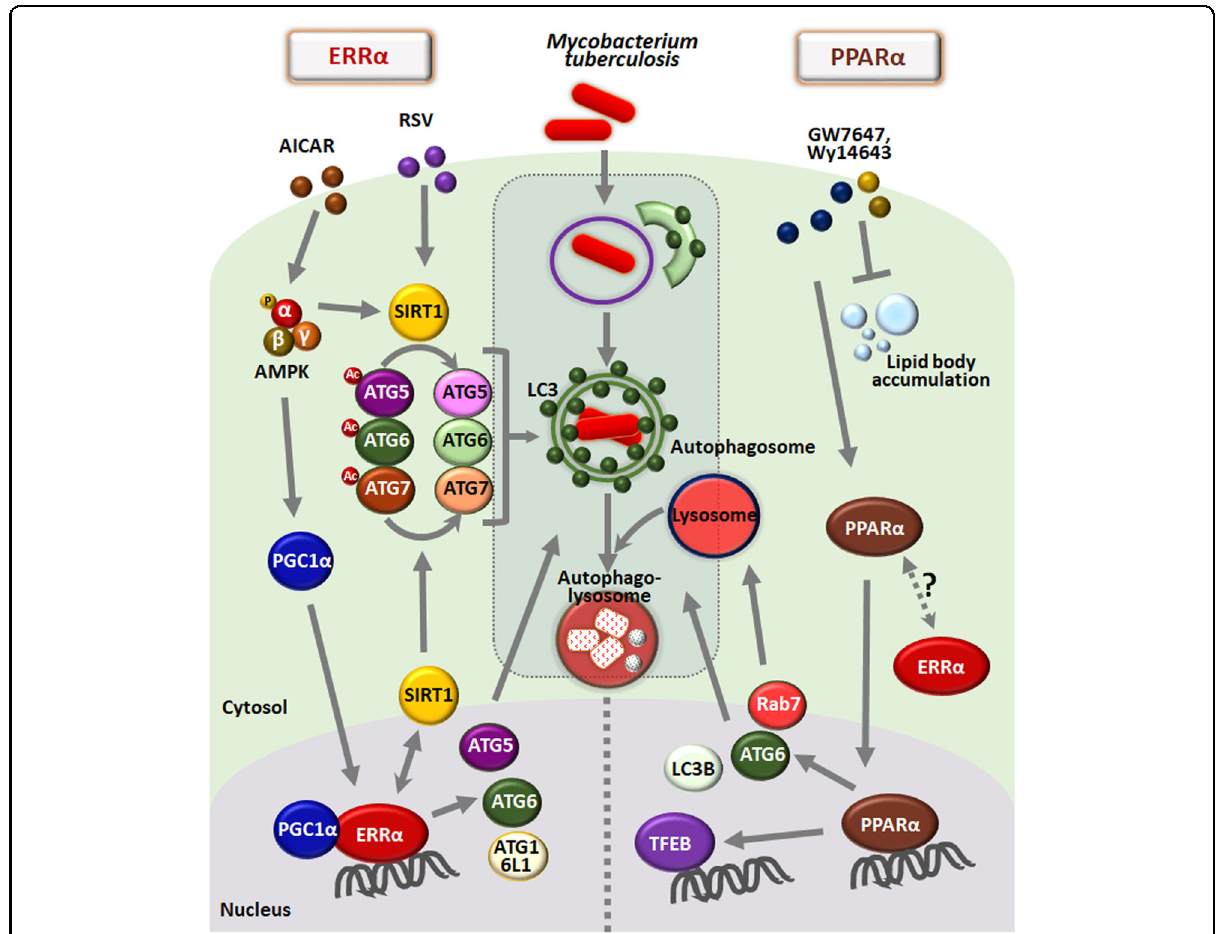
Fig. 2 The roles of ERR α and PPAR α in autophagy and host defense against Mtb infection. ( Left ) ERR α , which is induced by either AMPK or SIRT1 activation, contributes to the induction of autophagosome formation in BMDMs. ERR α is required for the transcriptional activation of several ATGs containing ERR response elements in the promoters. In addition, the cooperation of ERR α with SIRT1 promotes the deacetylation of ATG5, ATG6, and ATG7, thereby activating autophagy at the posttranslational level. ERR α -mediated autophagy activation results in increased phagosomal maturation and antimicrobial responses during Mtb infection. ( Right ) PPAR α , which is activated by PPAR α ligands (GW7647 and Wy14643), contributes to enhanced autophagosomal formation and maturation in BMDMs. PPAR α is essential for the transcriptional activation of several ATGs, TFEB and lipid catabolism. PPAR α reinforces antimicrobial responses to mycobacterial infection by inducing autophagic maturation, TFEB, and